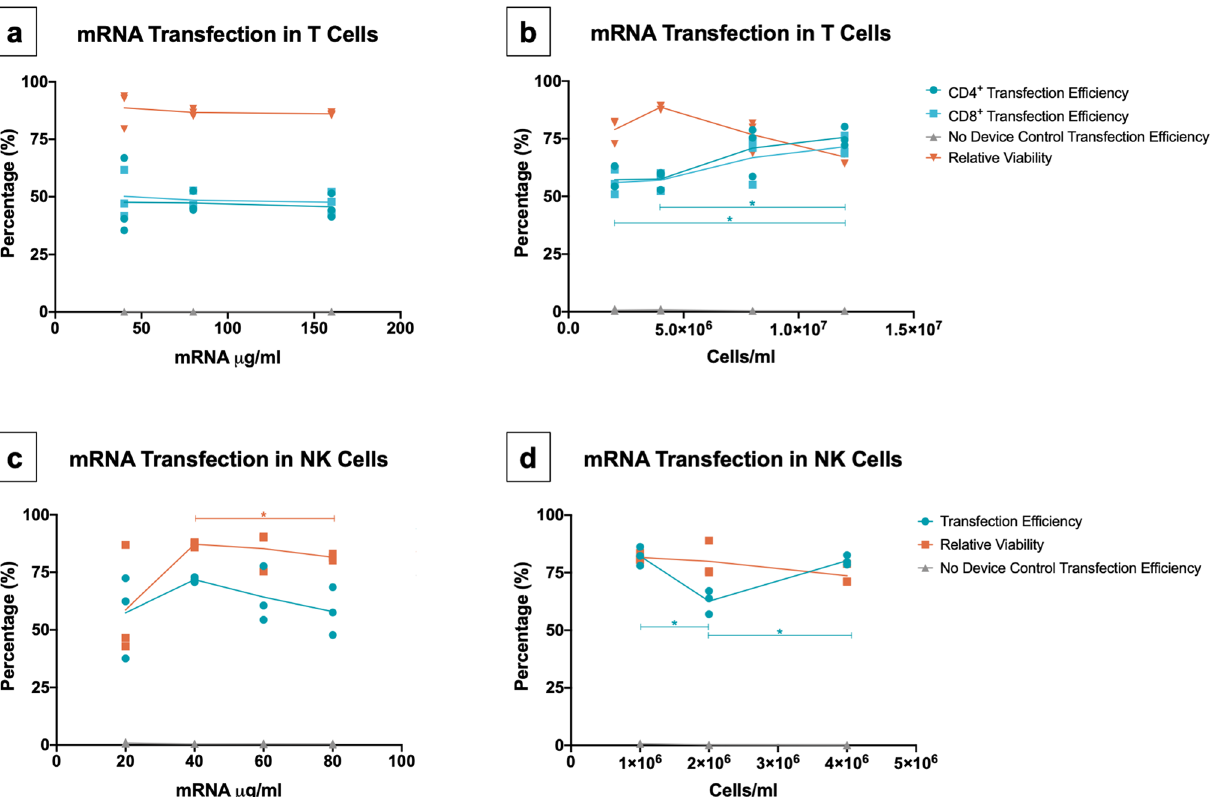
Figure 2. Operational ranges for the transfection of T cells and NK cells with mRNA employing the VECT microfluidic device. ( a ) Effect of mRNA concentration on mRNA VECT transfection of T cells (Mean and individual values, n = 3). Significant differences were not found in CD4 + transfection efficiency, CD8